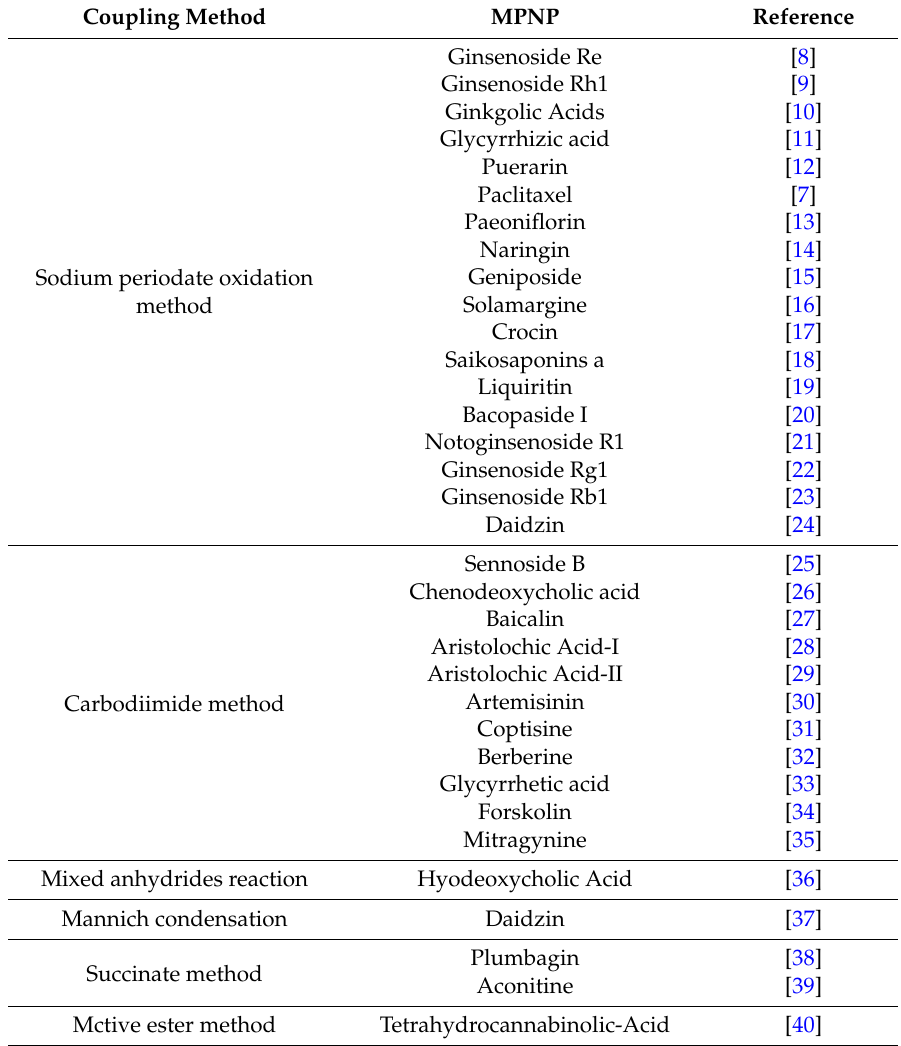
Table 1. Coupling methods between carrier protein and medical plant-derived natural products (MPNP) that were applied in the synthesis of MPNP artificial